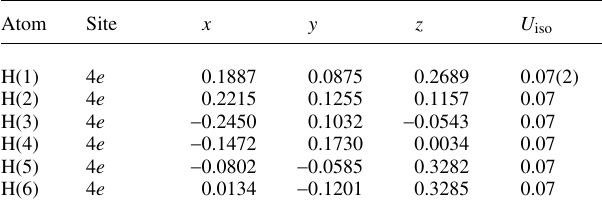
Table 7. Data collection and handling.